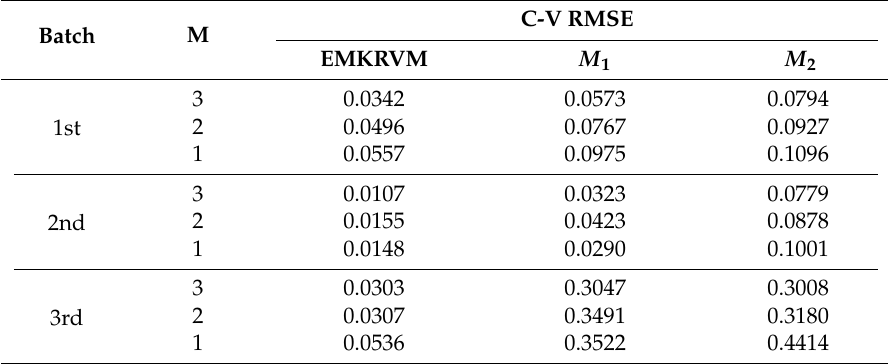
Table 7. Comparison results of C-V RMSEs of three